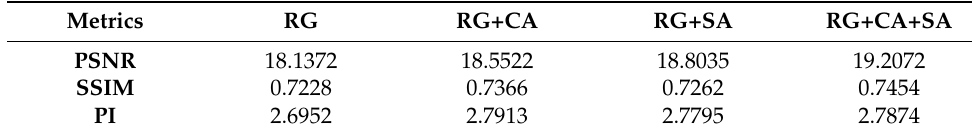
Table 5. Quantitative results with different attention module on NTIRE dehazing challenge datasets.